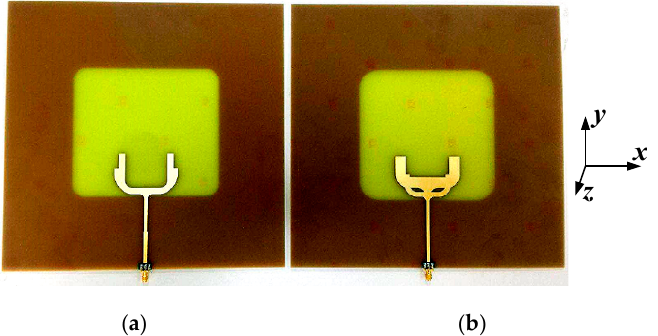
Figure 8. Photographs of the fabricated antennas with a soldered SMA connector; ( a ) antenna A; ( b ) antenna B.